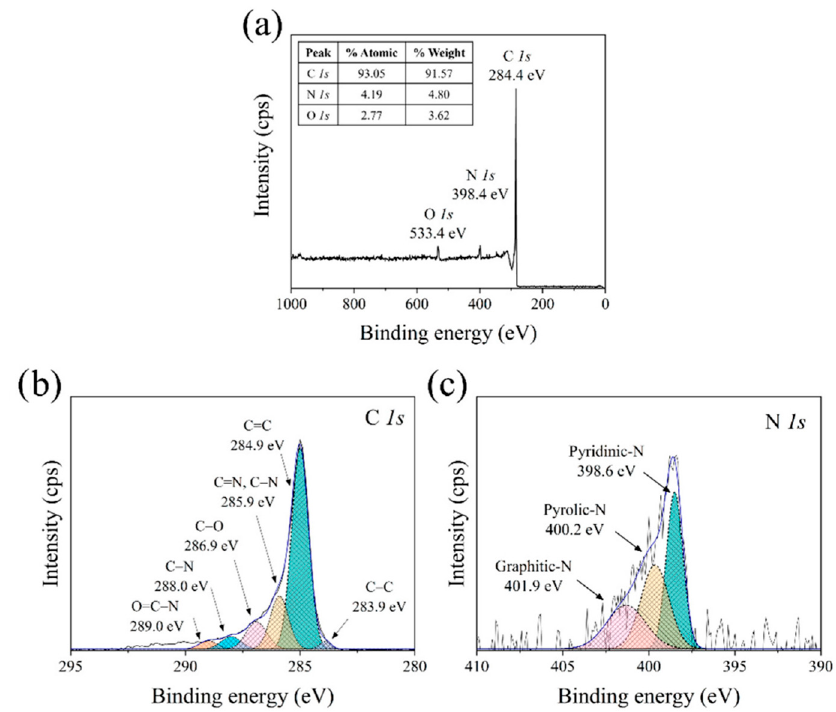
Figure 3. ( a ) XPS survey spectra equipped with element percent inset, and the high magnified XPS curve fitting of ( b ) C 1s and ( c ) N 1s spectra of prepared NrGO.